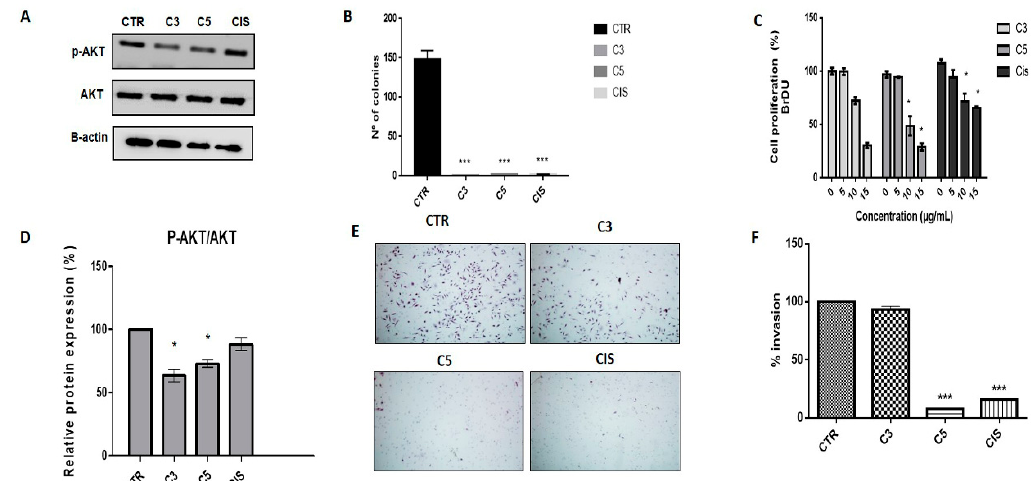
Figure 2. Cell proliferation and invasion upon C3 and C5 treatment (5µg/mL) in SiHa cells ( A ) Western blotting of phospho-AKT (protein kinase B) upon C3 and C5 treatment. ( B ) Number of colonies in the soft agar assay performed for 45 days. ( C ) BrdU incorporation after C3 and C5 treatment ( p < 0.0001) in SiHa cells. ( D ) Densitometry of p-AKT. ( E ) Invasion inhibition through C3 and C5 treatments in SiHa cells. ( F ) Percentage of invasion cells in SiHa cells (*** p < 0.0001; * p < 0.05). * Indicates statistical difference between the treatments). C3: Ethyl acetate fraction; C5: Fraction enriched in acetogenin; Cis: cisplatin.